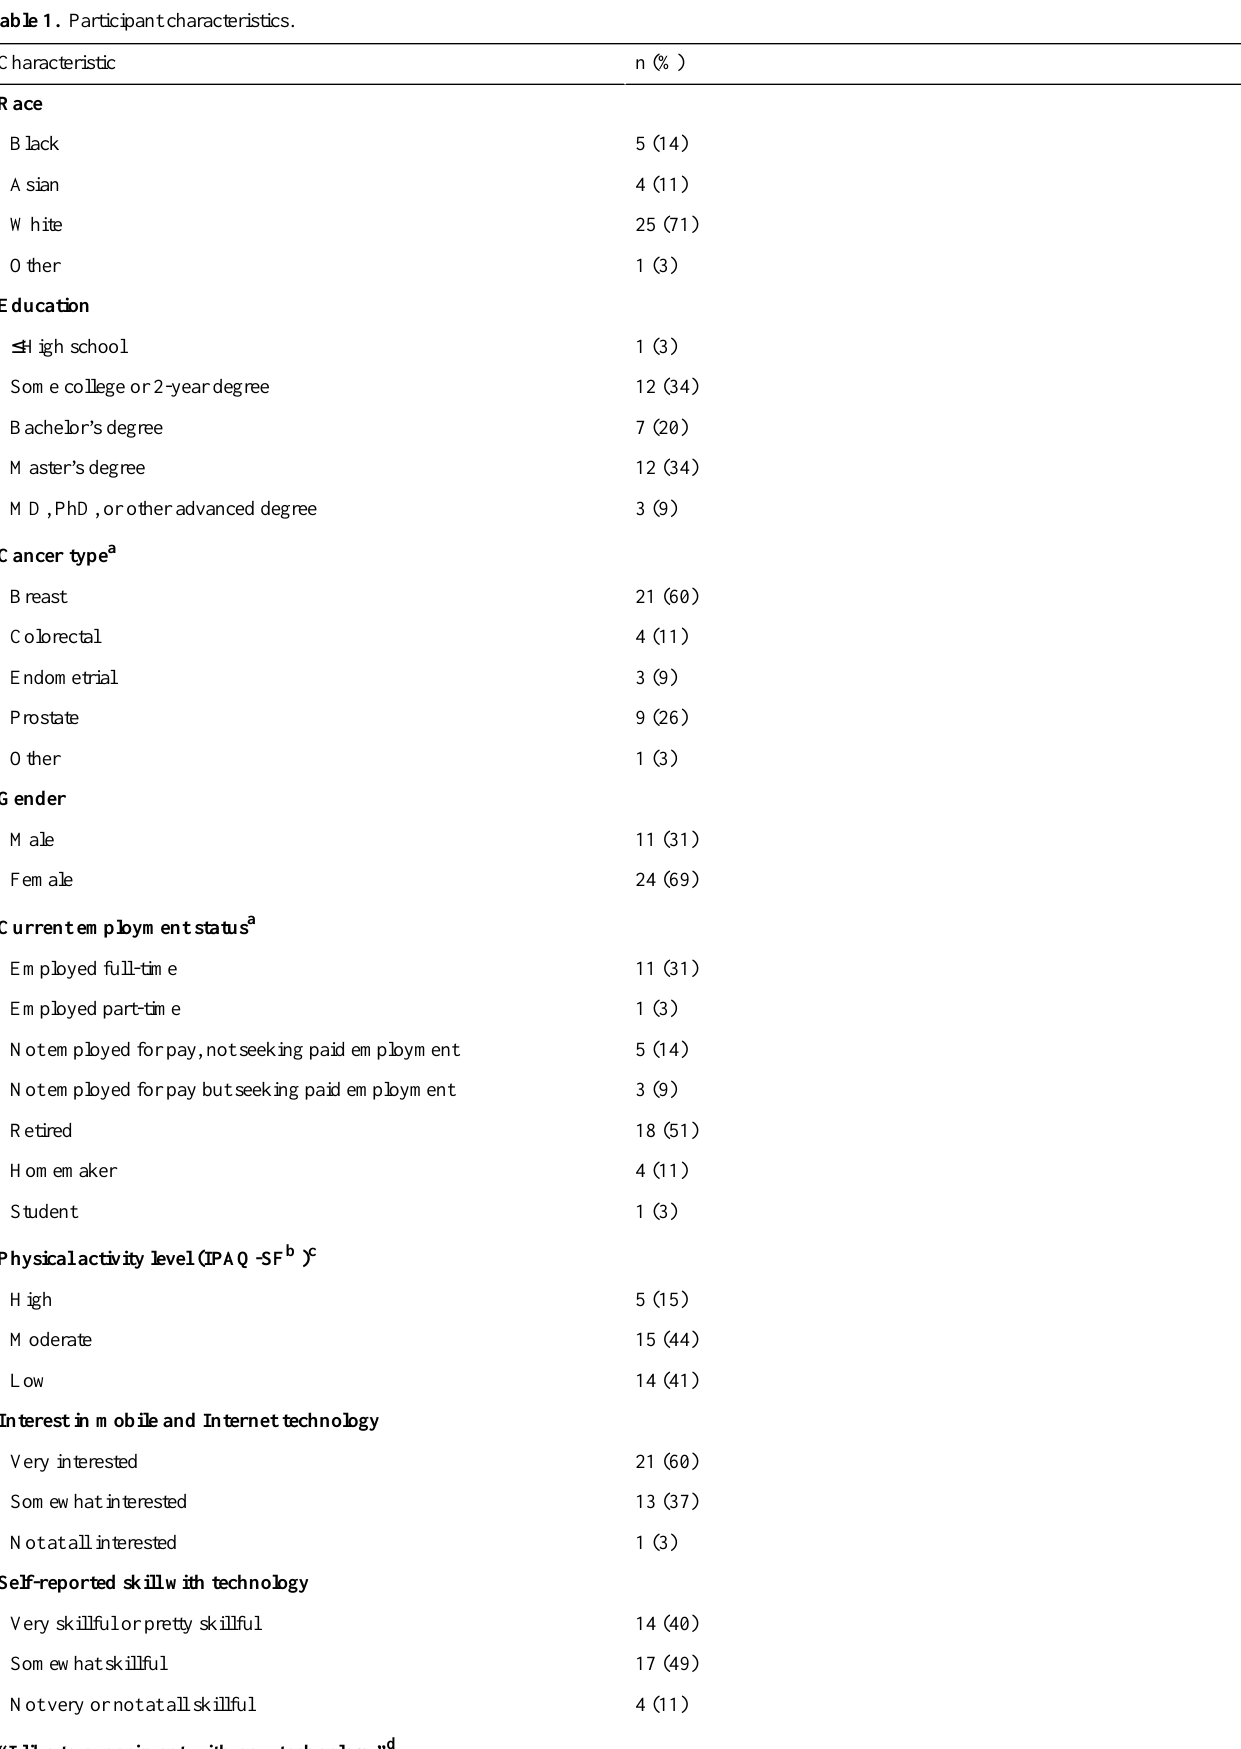
Table 1. Participant